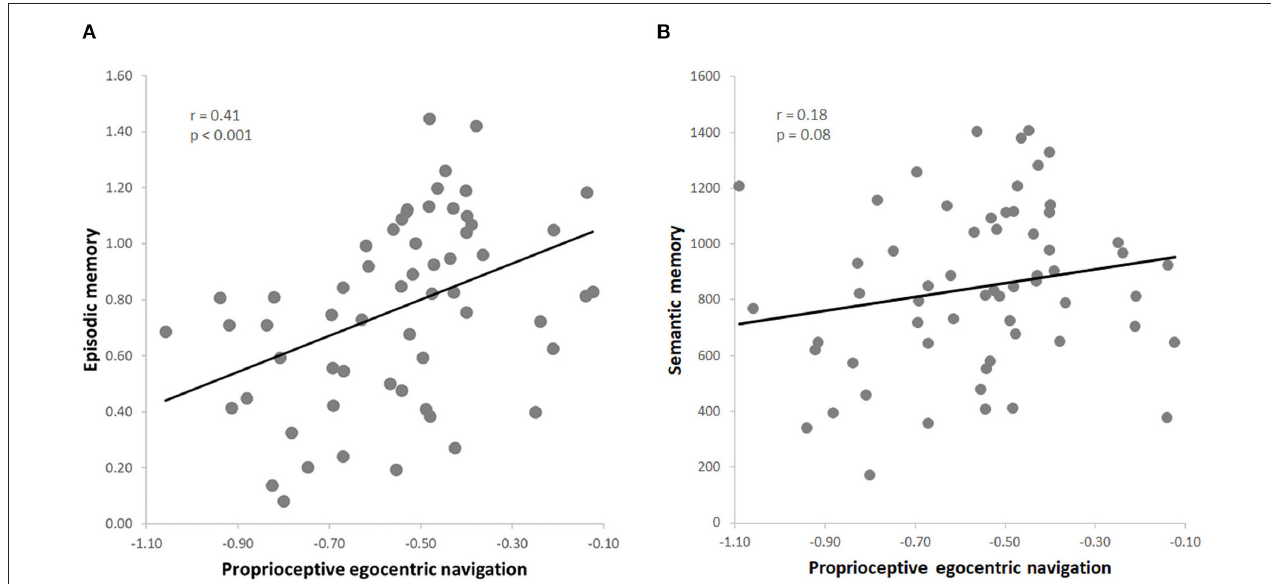
FIGURE 2 | (A) Skipped correlation between proprioceptive egocentric navigation (pTCT) and episodic memory (PRT); (B) skipped correlation between proprioceptive egocentric navigation (pTCT) and verbal semantic memory (GKW).